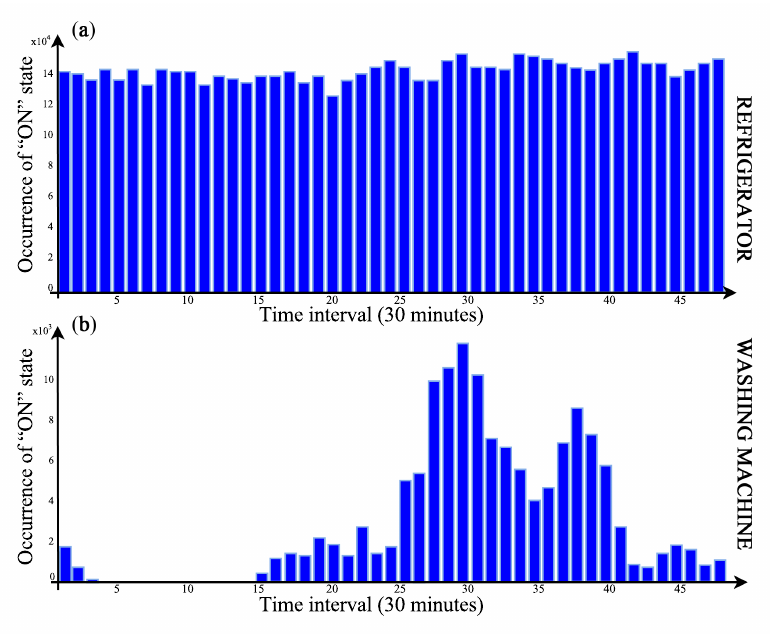
Figure 2. Usage statistics distribution for a refrigerator ( a ) and a washing machine ( b